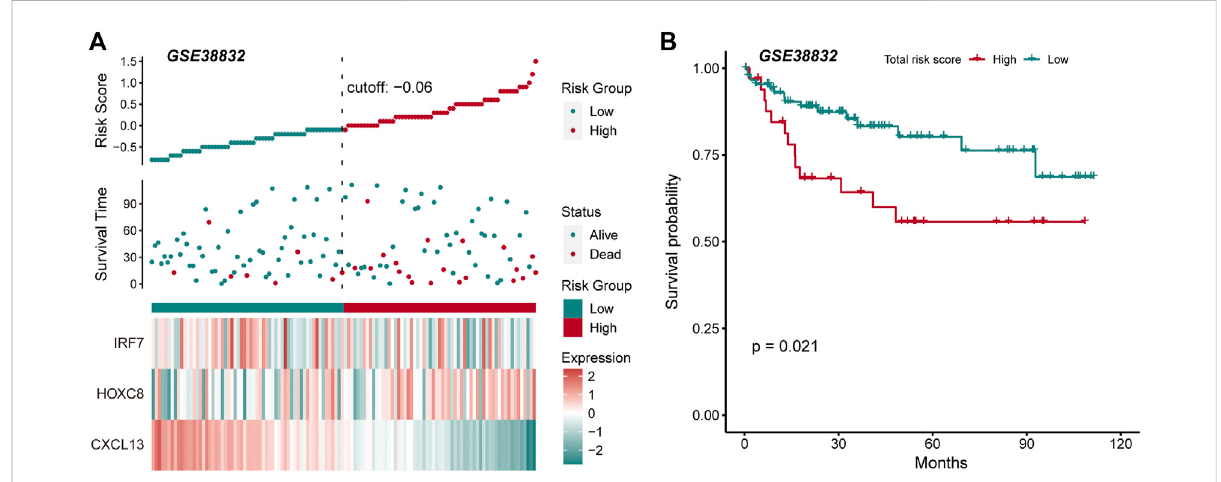
FIGURE 6 External data verify the robustness and stability of prognostic markers. (A) The fi gure shows the risk scores, survival status, and expression of prognostic markers for the GSE38832 set. (B) The Kaplan-Meier curves for the survival of high-risk and low-risk groups in the GSE38832